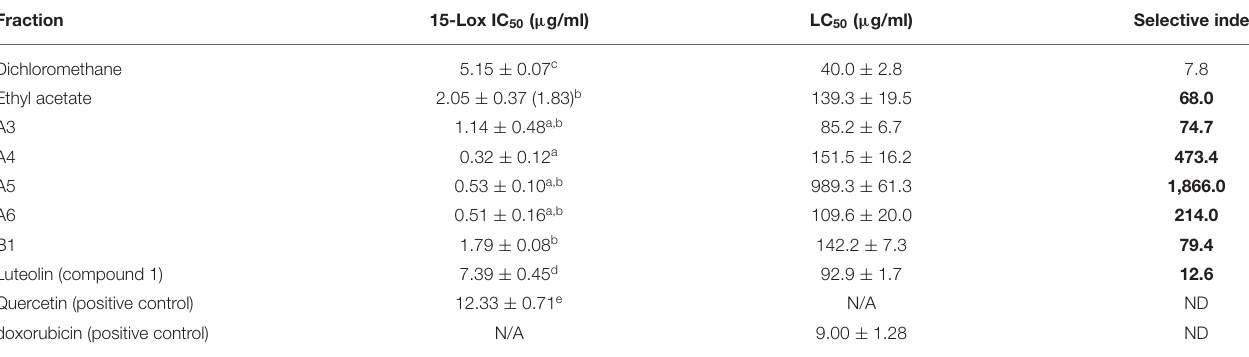
TABLE 4 | Anti-lipoxygenase activity of S. singueana fractions.